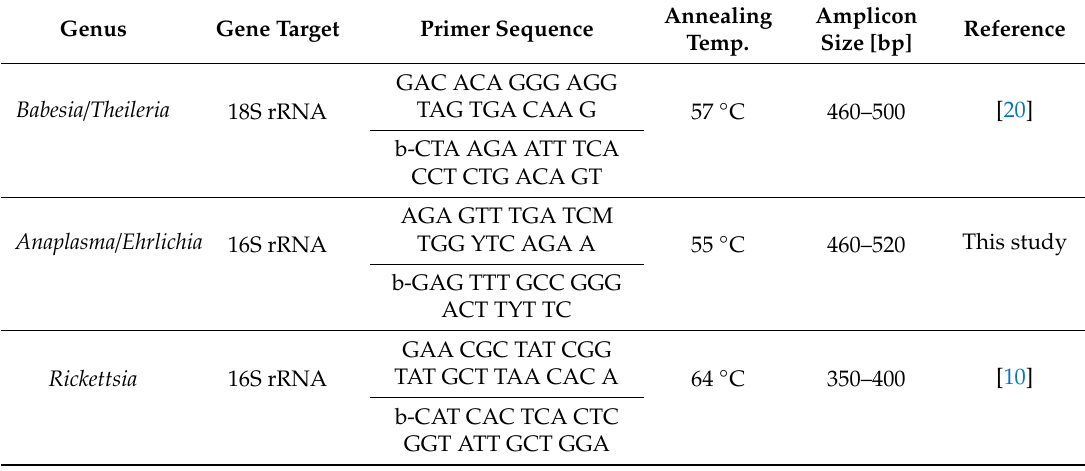
Table 1. Primer pairs used for identification of tick-borne